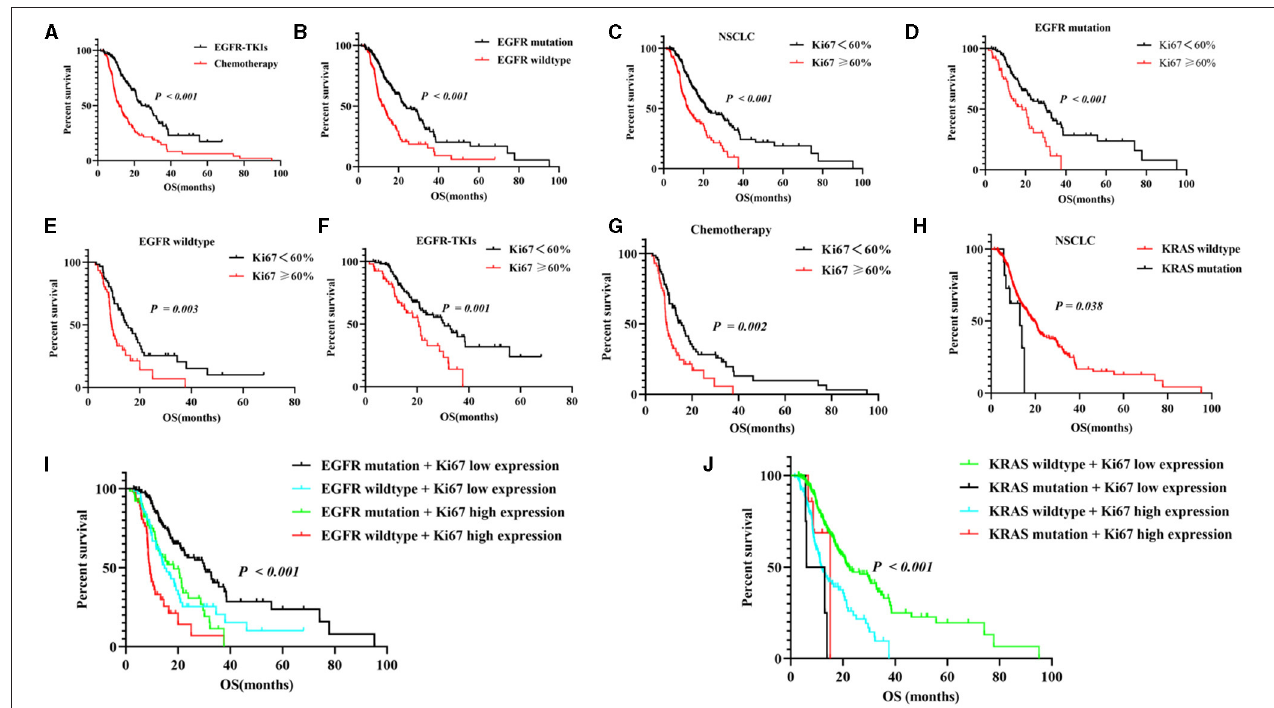
FIGURE 3 | Correlation between NSCLC and Ki-67 proliferation index and first-line therapeutic outcomes in NSCLC patients. (A) Compared to EGFR-TKIs and chemotherapy for OS; (B) compared to EGFR mutation and EGFR wildtype for OS; (C) the two Ki-67 groups and survival curve for first-line treatment in all NSCLC patients; the subgroup analysis of Ki-67 expression levels and survival curve in EGFR mutation (D) , EGFR wildtype (E) , EGFR-TKIs (F) or chemotherapy groups (G) ; (H) the relationship between Ki-67 expression and KRAS-mutant status. (I,J) the subgroup analysis of the correlation between Ki-67 expression correlation and EGFR-mutant status or KRAS-mutant status. EGFR-TKIs, epidermal growth factor receptor tyrosine kinase inhibitor, OS, overall